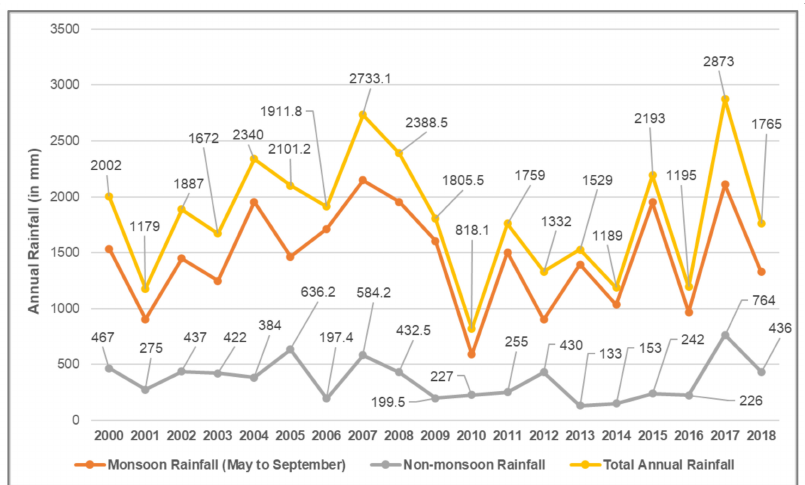
Figure 15. Rainfall pattern of the DMDP